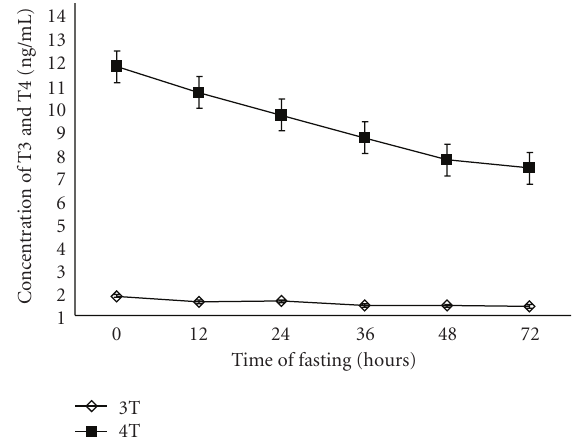
Figure 3: Concentration of T3 and T4 (ng/ml) in experimentally pregnant toxemic goats. Di ff erences in the letters indicate beginning of the significant di ff erences.